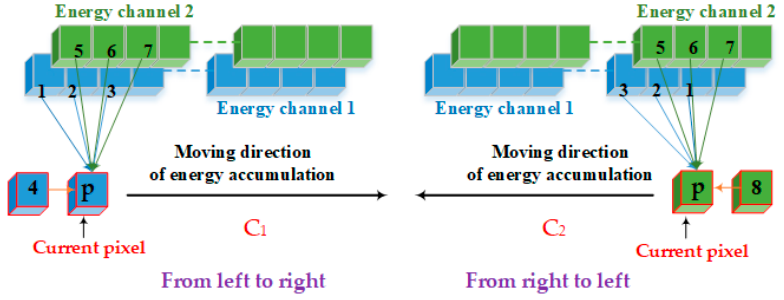
Figure 5. Schematic diagram of our search strategy.